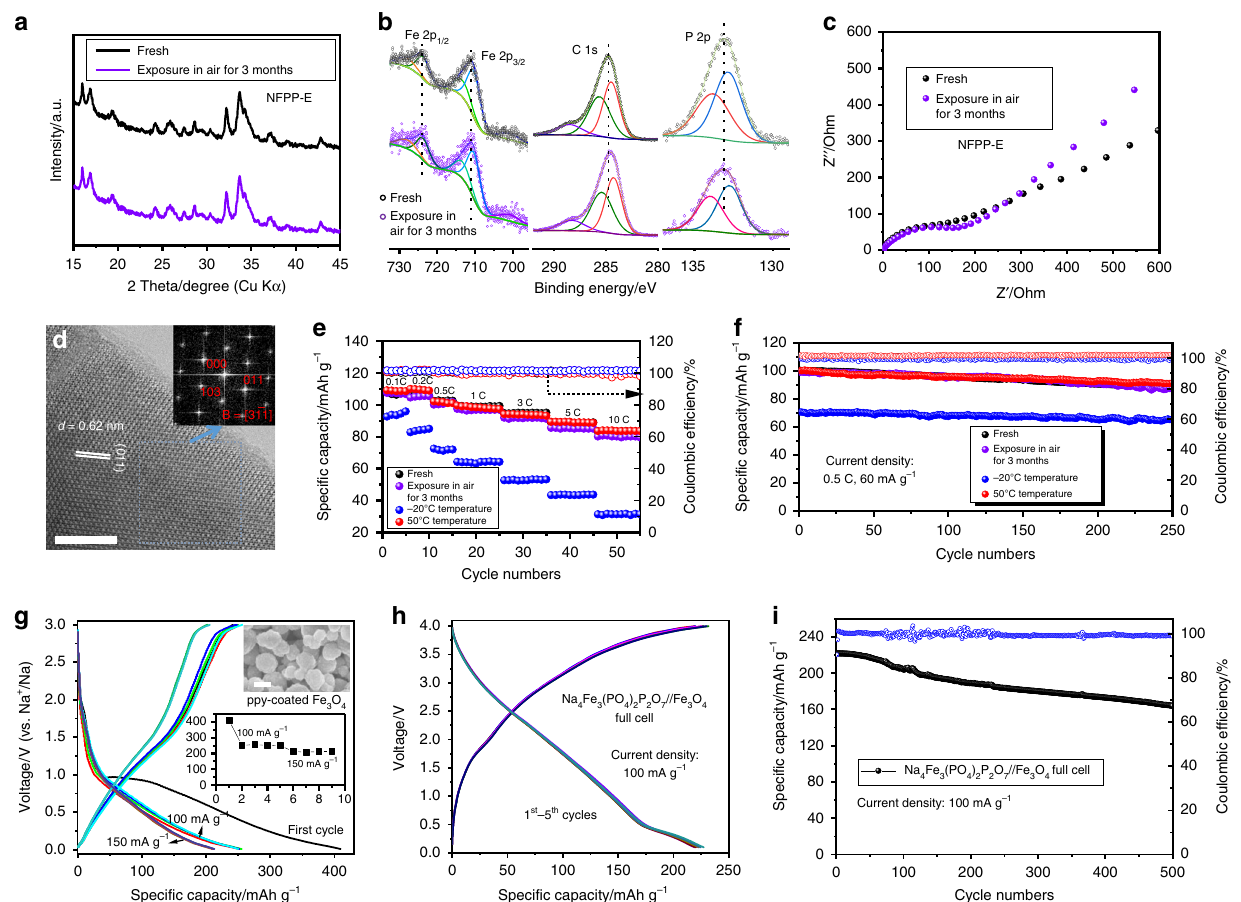
Fig. 3 Air stability, low/high-temperature performance, and full cell performance. a XRD comparison of NFPP-E powder in the fresh state and after exposure to air for three months (Cu K α radiation, λ = 1.5406 Å). b Fe 2p, C 1s, and P 2p XPS fi tted spectra of NFPP-E powder in the fresh state and after exposure to air for three months. c EIS spectra of NFPP-E powder in the fresh state and after exposure to air for three months. d HRTEM image of the powder after exposure to air for three months. The inset is the fast Fourier transform (FFT) pattern of the marked area. e C-rate capability of NFPP-E electrodes: fresh, exposed to air for three months, and fresh at both − 20 °C and 50 °C. f Cycling performances of the four electrodes in e . g Charge/ discharge curves of polypyrrole (PPy)-coated Fe 3 O 4 at various current densities. The insets are (top) SEM image of as-prepared Fe 3 O 4 nanospheres and (bottom) the cycling performance. h Voltage pro fi les of the all-iron-based Na 4 Fe 3 (PO 4 ) 2 (P 2 O 7 )//Fe 3 O 4 full cell for the fi rst fi ve cycles. i Cycling stability of the Na 4 Fe 3 (PO 4 ) 2 (P 2 O 7 )//Fe 3 O 4 full cell. The speci fi c capacities of the full cell were all based on the anodes. Scale bars: 10 nm ( d ); 200 nm ( g ,